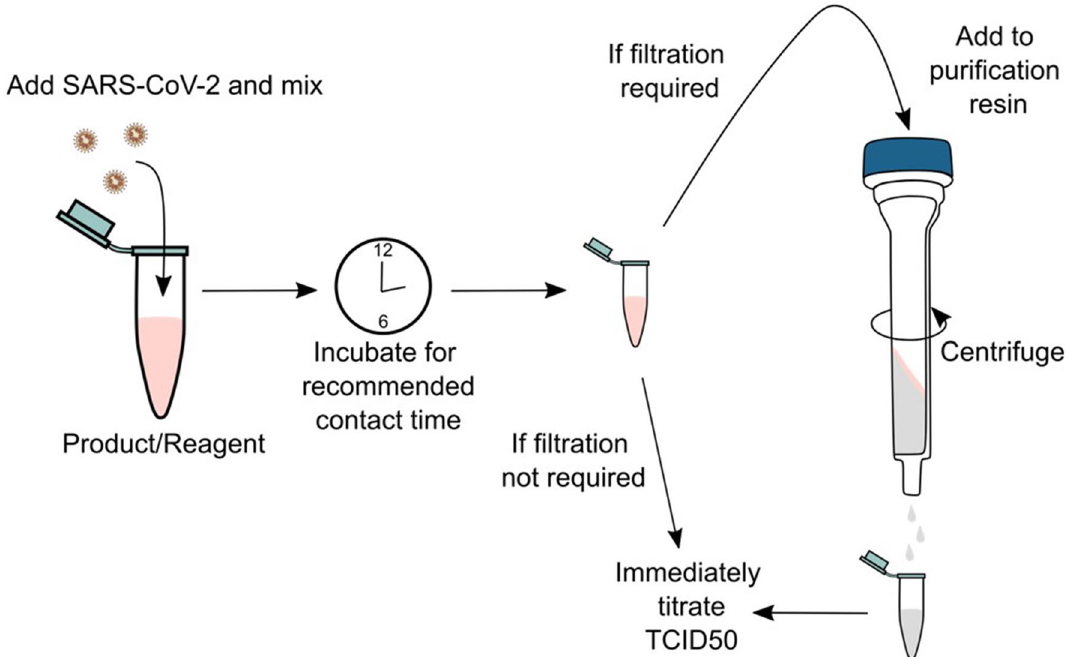
Figure 1. Inactivation testing workflow. SARS-CoV-2 suspensions are treated with guanidine-free molecular extraction reagents or LFIA buffers and mixed before incubating for the recommended contact time. If filtration is required to remove product-associated cytotoxicity, samples are added to a purification resin and centrifuged to elute and immediately titrated. If filtration steps are not required, samples are immediately titrated. Image created in Inkscape version 1.0 https:// inksc ape.